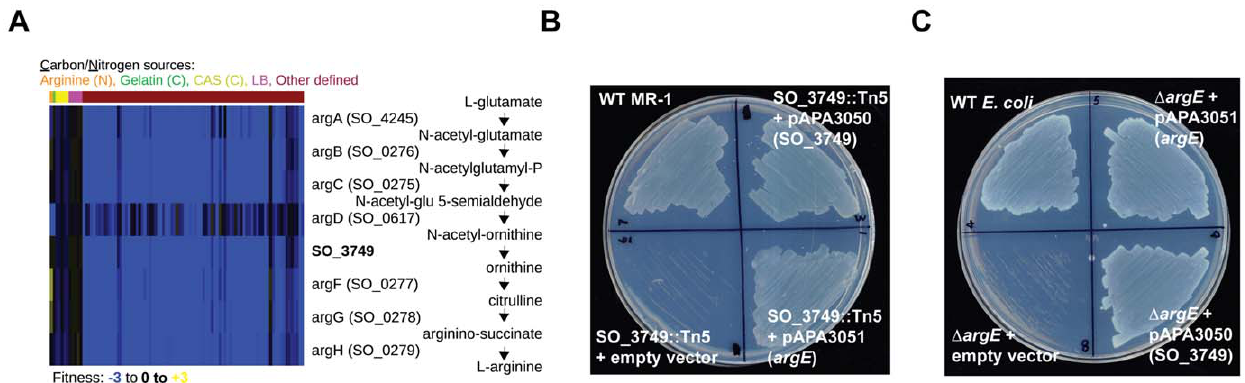
Figure 4. SO_3749 encodes a functional N-acetyl-ornithine deacetylase. (A) Fitness heatmap for genes of the arginine biosynthesis pathway and SO_3749, annotated as a hypothetical protein. (B) Growth of wild-type MR-1 and a SO_3749 transposon mutant on minimal media with DL- lactate as a carbon source. The auxotrophy of the SO_3749 mutant is complemented by the E. coli argE gene (bottom right). (C) Same as (B) for wild- type E. coli and an argE deletion mutant. The auxotrophy of the E. coli argE mutant is complemented by MR-1 SO_3749 (bottom